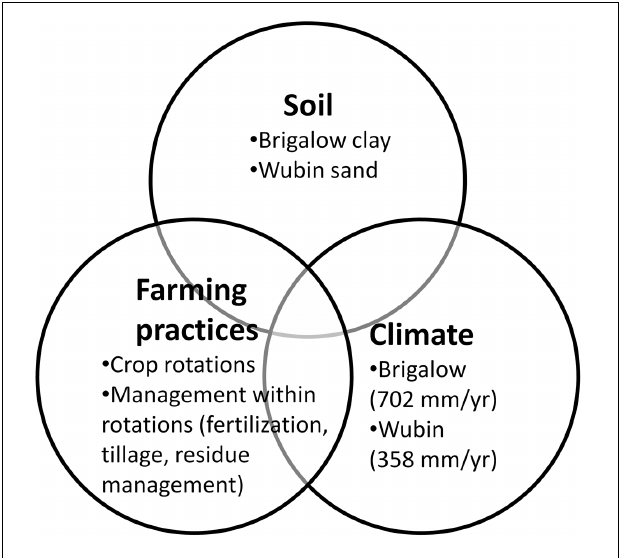
FIGURE 1 | The study analyzed the influences of the interactions of soil, climate, and farming practices on soil organic carbon (SOC) by undertaking a factorial analysis of contrasting soils, contrasting climates and farming